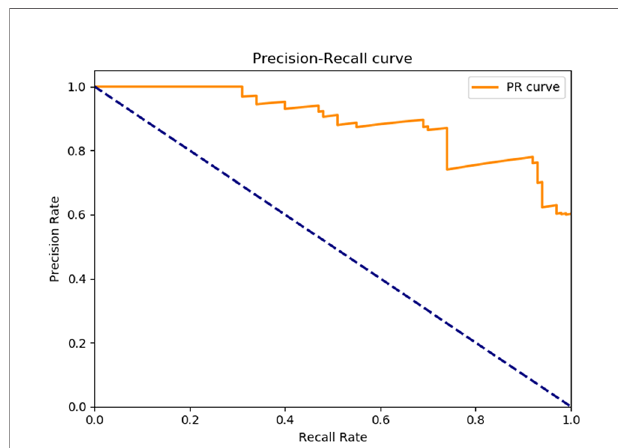
FIGURE 4 | The precision-recall curve of the Faster R-CNN training process. The mAP of the main collection is the average of the average precisions from all classes. When the mAP value is closer to 100%, Faster R-CNN identi fi cation is more precise. mAP, Mean average precision; R-CNN, Region- based convolutional neural network.